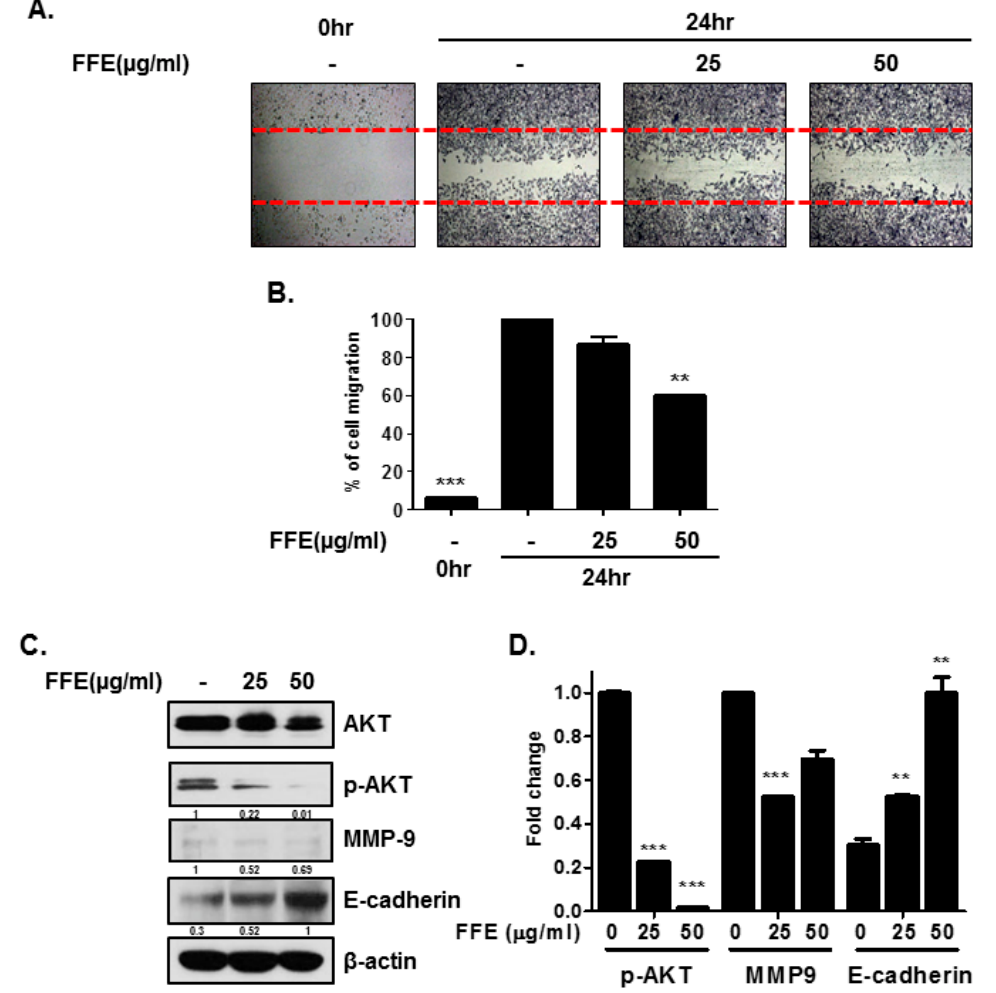
Figure 4. Inhibitory Effect of FFE on cell migration in MDA-MB-231 cells. Cells treated with FFE for 24 h, and cell migration was assayed by wound healing assay. ( A ) The number of cells migrating into the scratched area photographed ( × 100) and ( B ) calculated as a percentage of migration. Data represent mean ± SD, ** p < 0.01 and *** p < 0.001 compared with control. ( C ) MDA-MB-231 cells treated with FFE (25 or 50 µ g/mL) for 24 h. Cell lysates used for Western blotting (AKT, p-AKT, MMP-9, E-cadherin and β -actin). ( D ) Fold change of Western blot. Data represent mean ± SD, * p < 0.05, ** p < 0.01 and *** p < 0.001 compared with control.